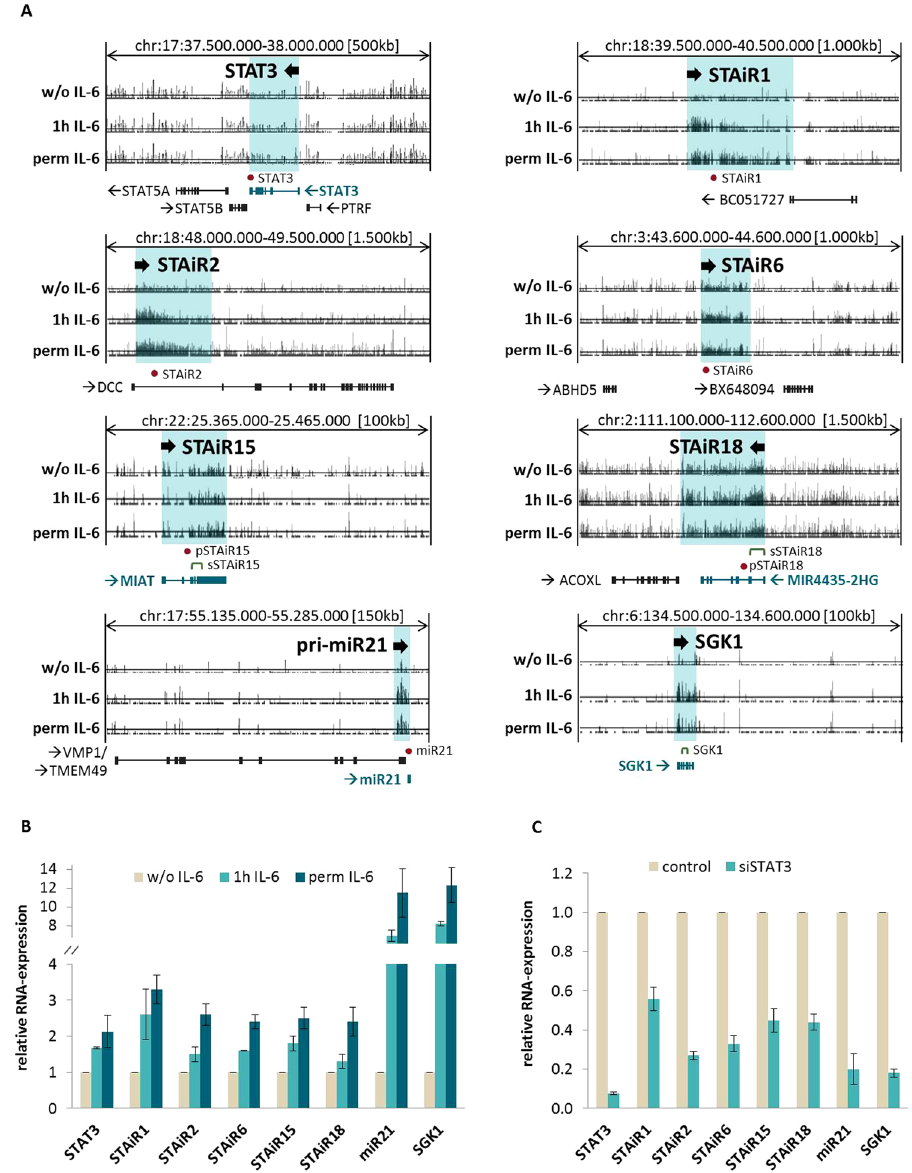
Figure 1. Identification and validation of STAT3-induced ncRNAs (STAiRs). ( A ) Expression profiles of STAiRs and control genes upon IL-6 treatment after tiling array analysis and mapping to the human genome hg18. INA-6 cells were either permanently grown in the presence of IL-6 (perm IL-6) or withdrawn from IL-6 for 12 h (w/o IL-6), and subsequently restimulated with IL-6 for 1 h (1 h IL-6). ( B ) Validation of STAiR-induction by IL-6. RNA isolated from INA-6 cells treated as described above was prepared, reverse transcribed and relative gene expression was determined by qPCR. ( C ) STAiR expression is STAT3-dependent. Permanently IL-6- treated INA-6 cells were transfected with either an siRNA targeting STAT3 or a control siRNA. The cells were harvested 24 h post-transfection and RNA was isolated. Relative gene expression was determined by RT-qPCR. In each case, the STAT3 knockdown led to significant reductions (p < 0.05) of target gene expression. For both, ( B ) and ( C ), primer pairs used for STAT3 and SGK1 control mRNAs are intron-spanning and detect spliced transcripts, whereas primers used for all STAiRs as well as the miR21 detect primary, unspliced transcripts. Expression values were first normalized to U6 RNA and then compared to the corresponding negative control. Data are expressed as mean ± SD (n ≥